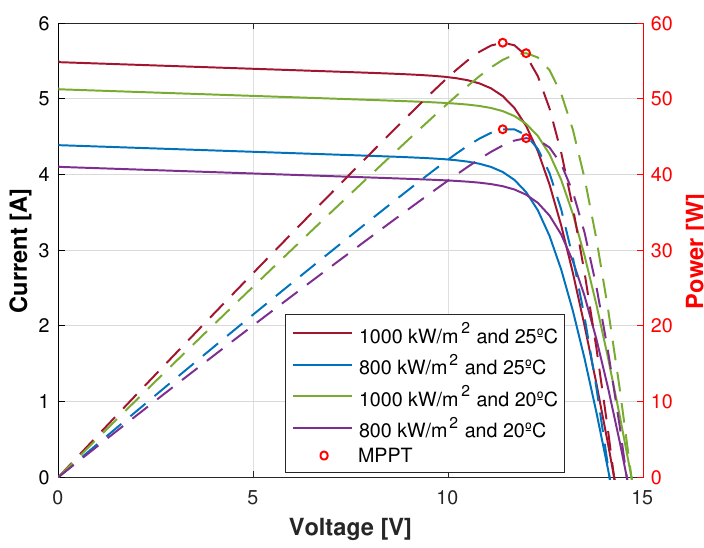
Figure 4. Current (left axis) and Power (right axis) against Voltage profiles, for different Irradiances and Temperatures input